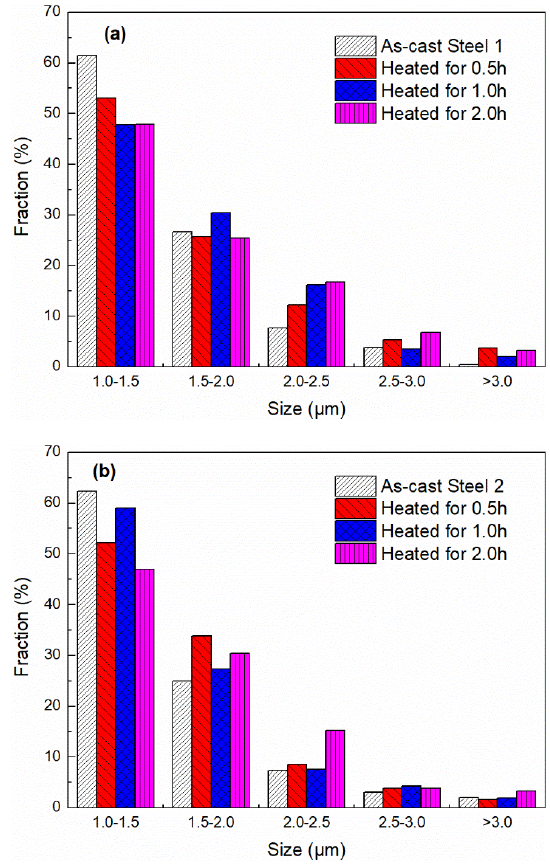
Figure 12. Size distribution of oxide inclusions after heating in steel #1 ( a ) and #2 ( b